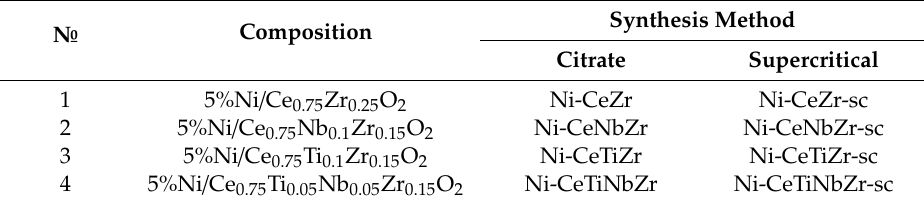
Table 1. Compositions and